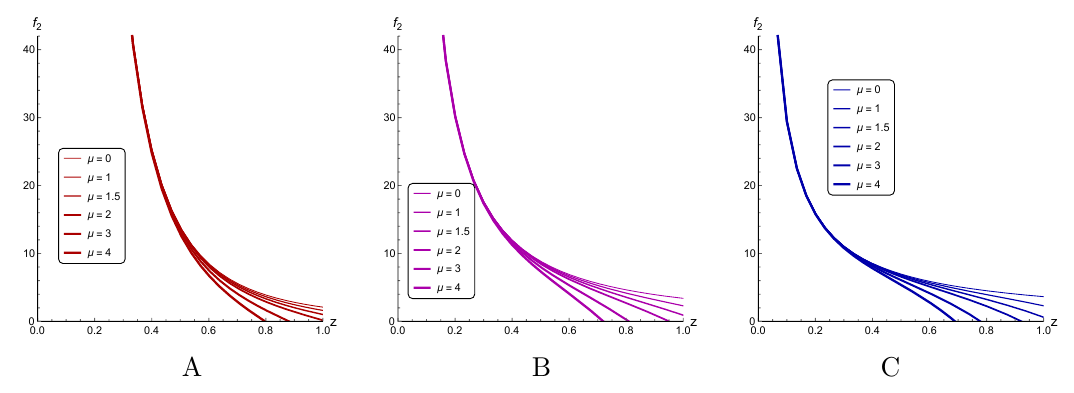
Figure 5 . Coupling function f 2 ( z ) for different µ in anisotropic cases ν = 1 . 5 (A), ν = 3 (B), ν = 4 . 5 (C); a = 4 . 046 , b = 0 . 01613 , c = 0 . 227 , z h = 1 and q = 1 .